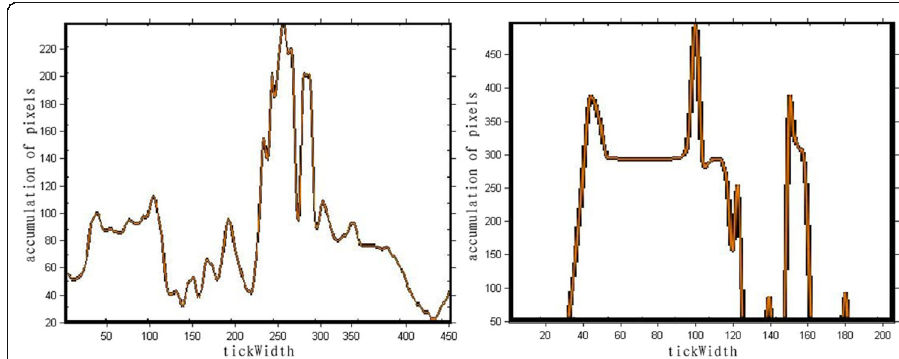
Fig. 8 Example of integration projection based on images in radial